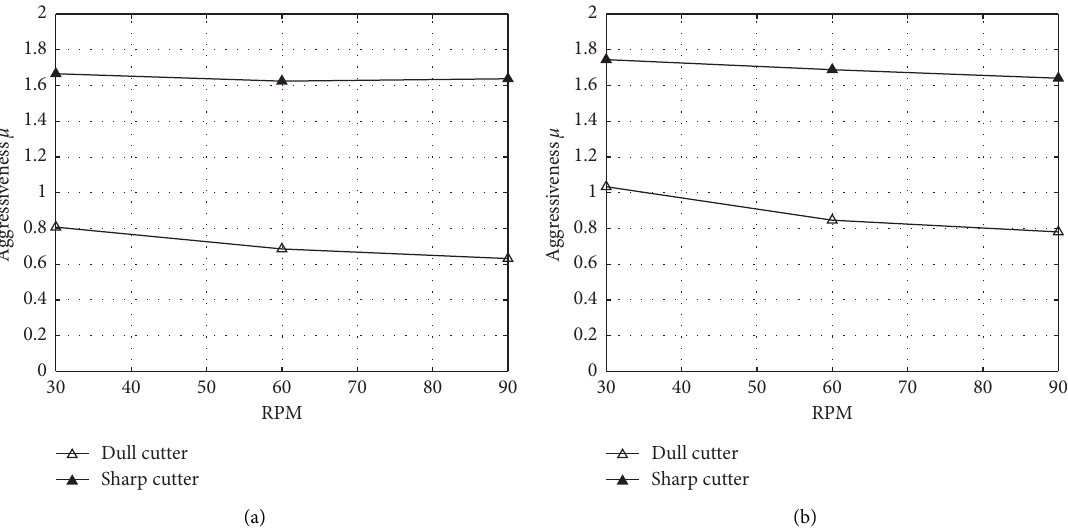
Figure 17: Efect of cutter wear state using the models with cutting speed dependency on (a) normal bond strength and (b) grain